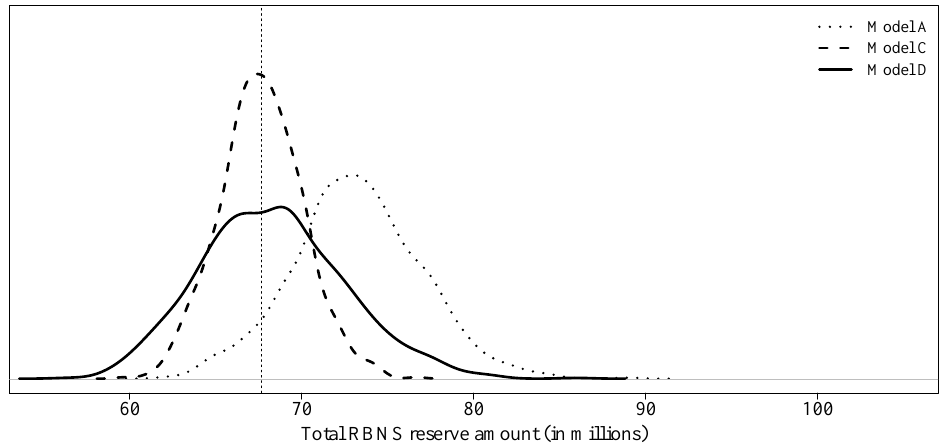
Figure 6. Predictive distributions (RBNS) for XGBoost models A, C and